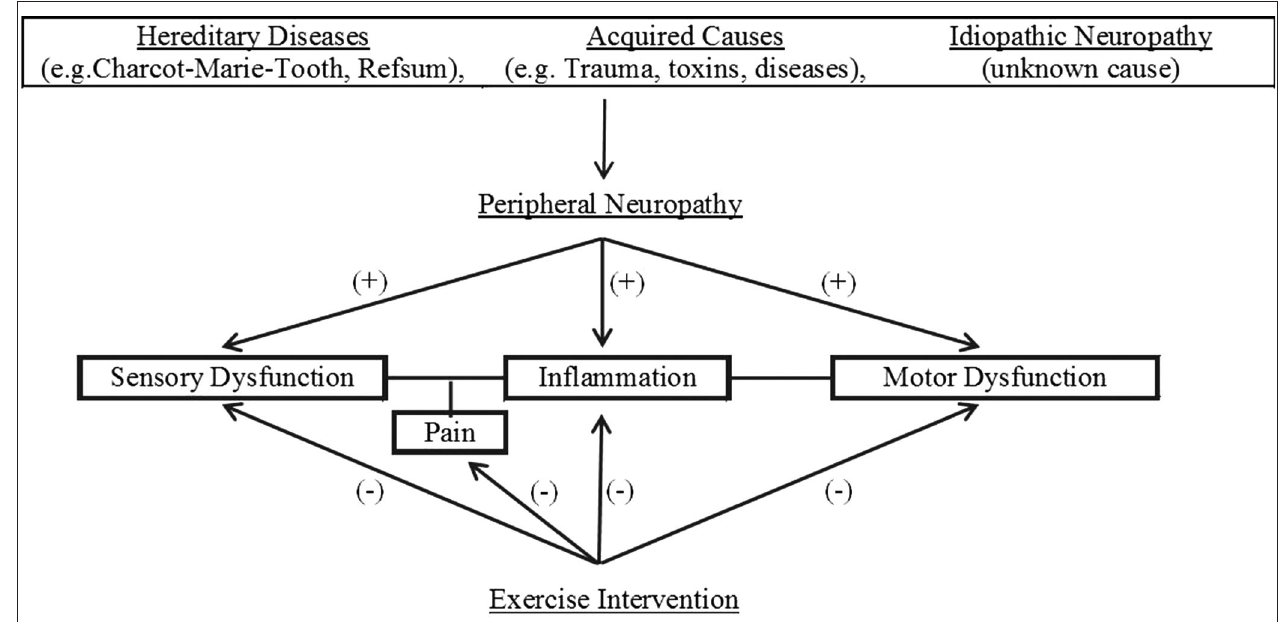
FIGURE 1 | Overview of potential benefits of exercise intervention on neuropathic